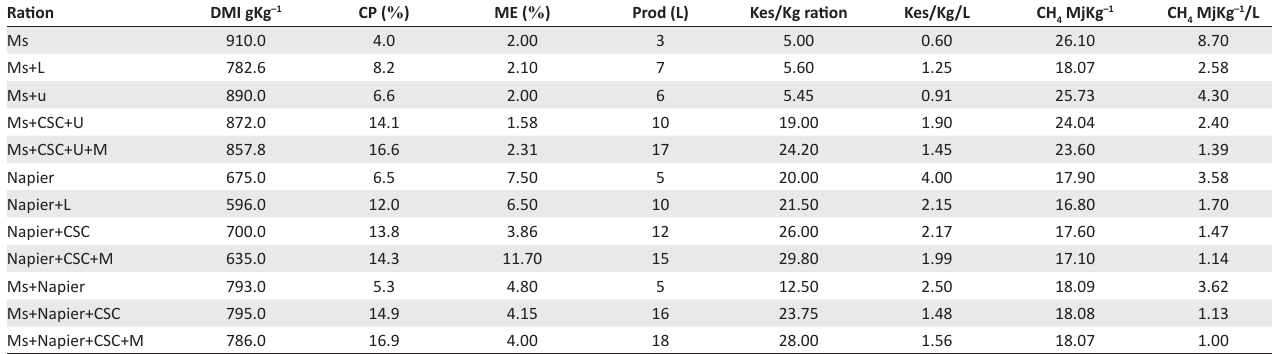
TABLE 1: Simulated effect of supplementation on milk and methane emission risks.